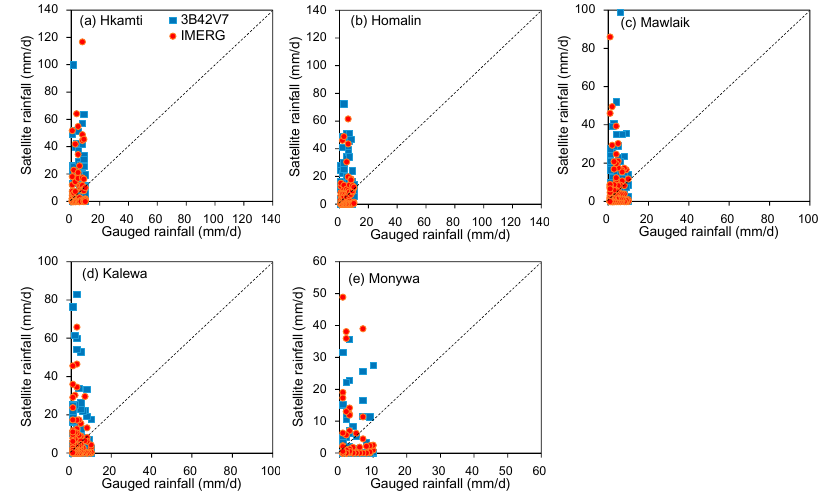
Figure 6. Scatter plots of light rain events from 3B42V7 and IMERG precipitation products against gauge-based precipitation data at the five weather stations in the Chindwin River basin (1 April 2014–31 December 2015).